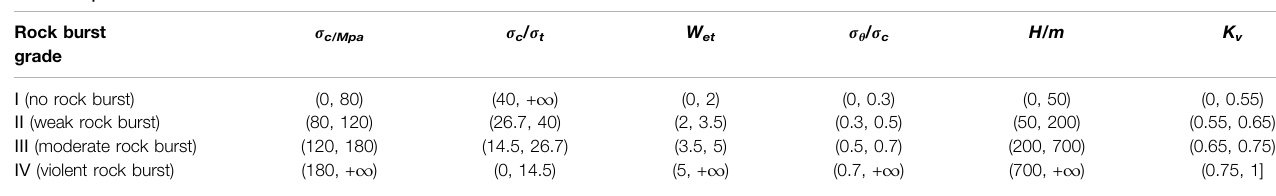
TABLE 1 | Rock burst classi fi cation criteria. Rock burst